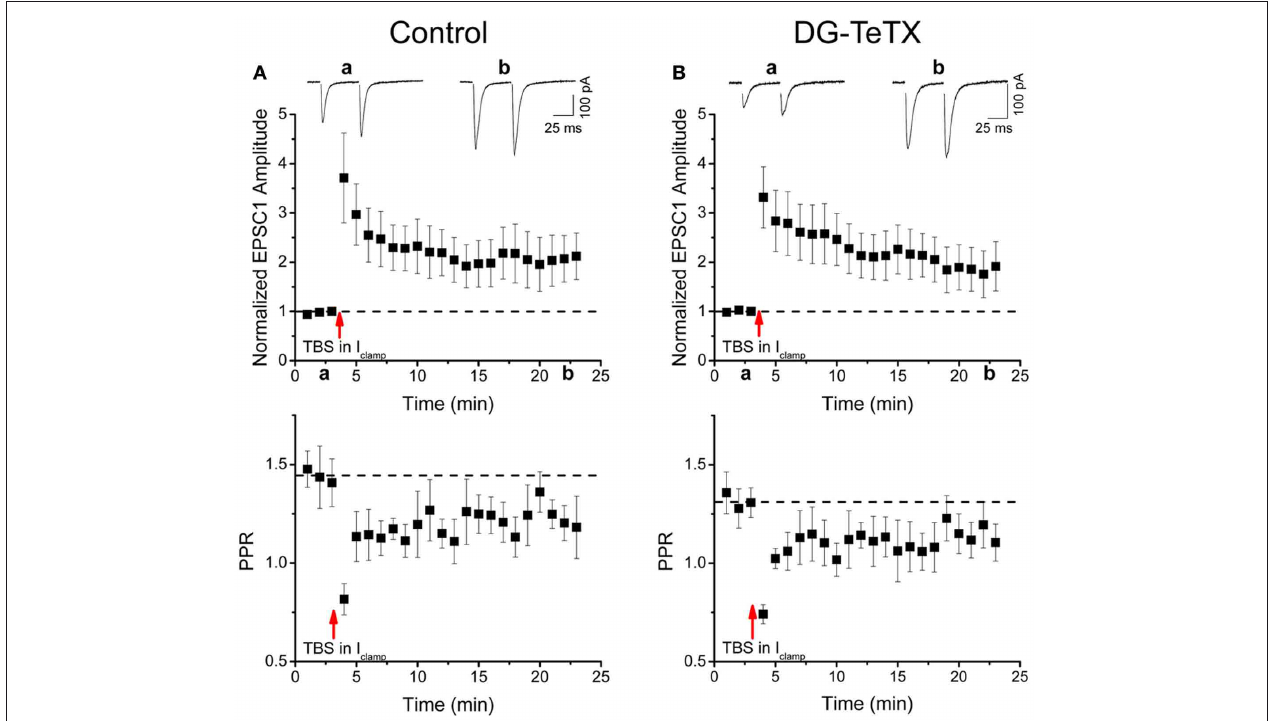
DG-TeTX ( B , n = 6 cells from 4 animals) mice. Inset traces show EPSCs taken at the times indicated on the x -axis. Lower panels show the corresponding pooled data time course plots of the paired pulse ratios for AMPA receptor-mediated EPSC peak amplitudes (PPRS) in control and activated DG-TeTX